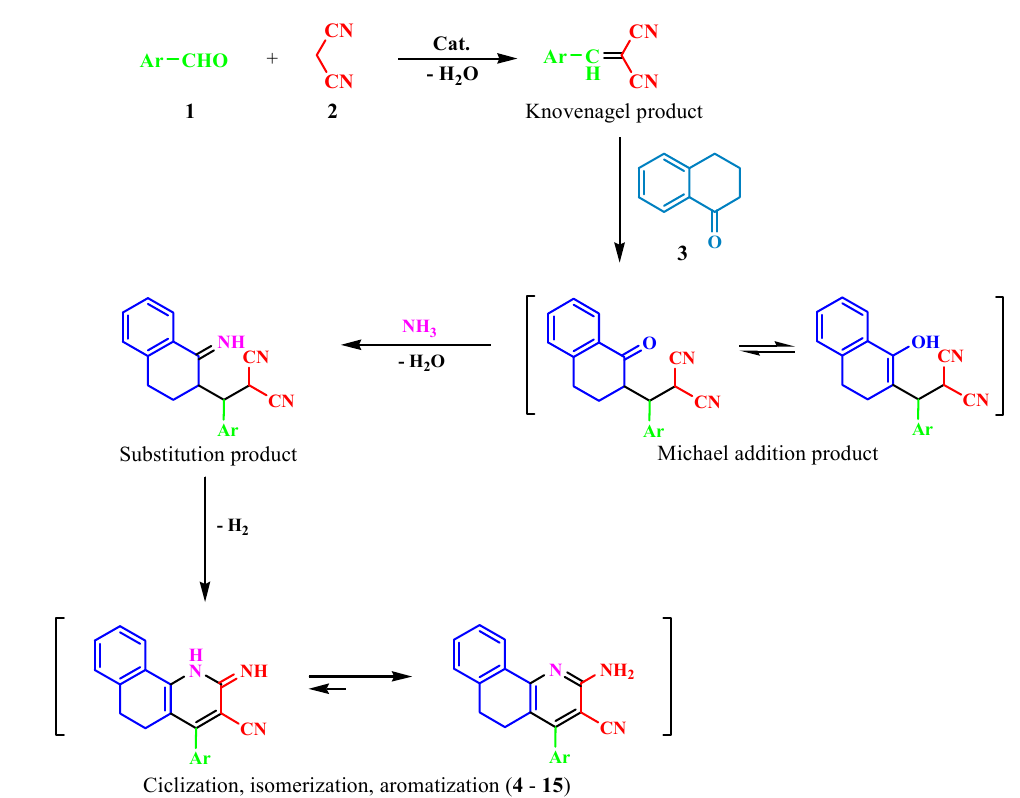
Scheme 2 . Proposed reaction mechanism for obtaining compounds 4 – 15 .